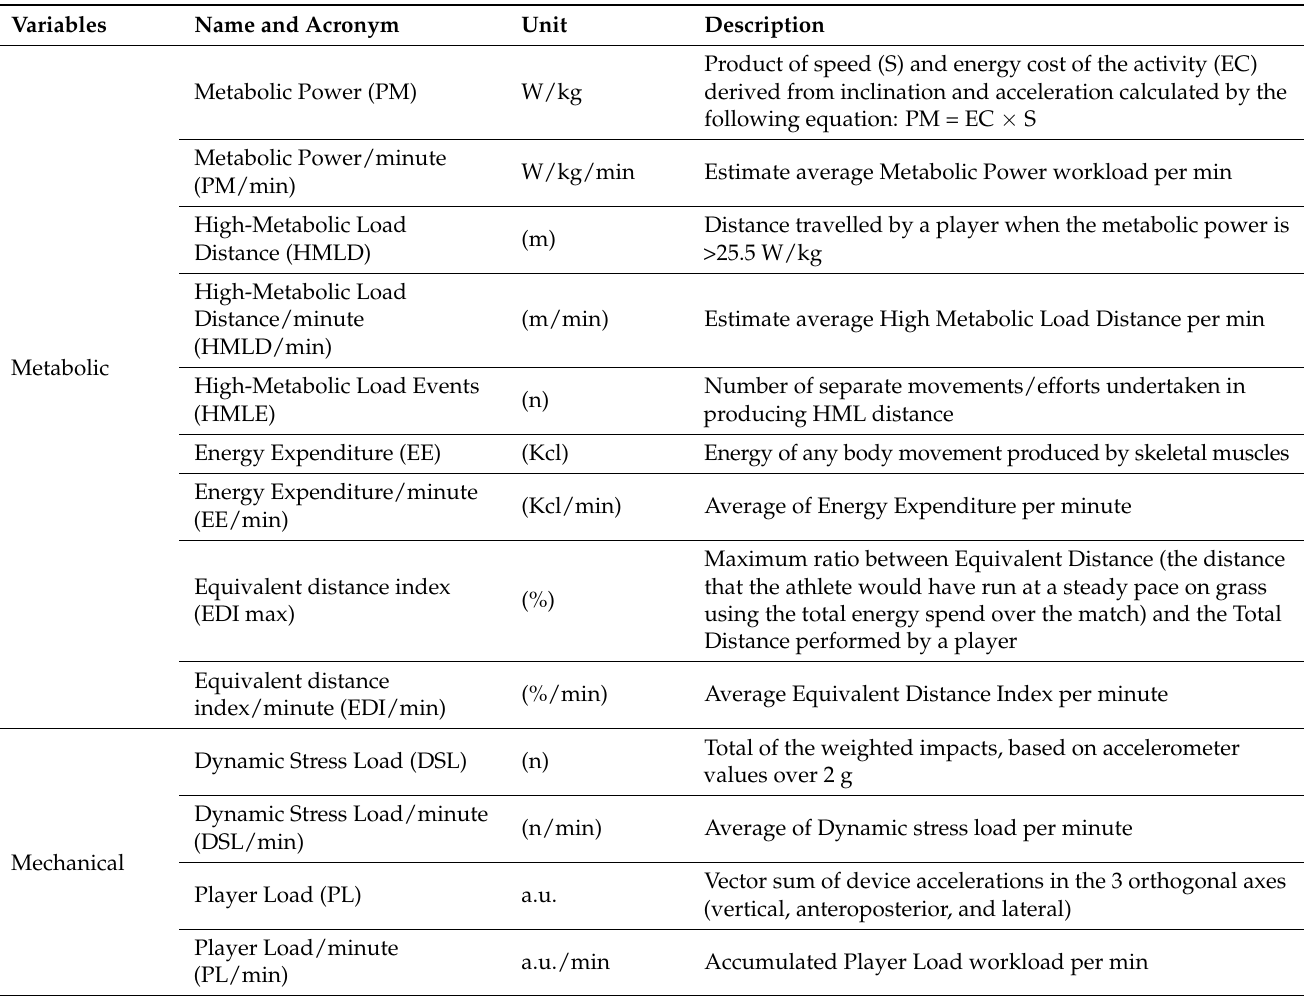
Table 1. Description of selected physical